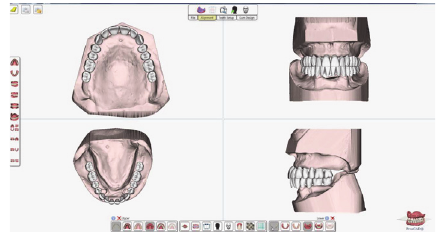
Figure 6: Digital design of the teeth.